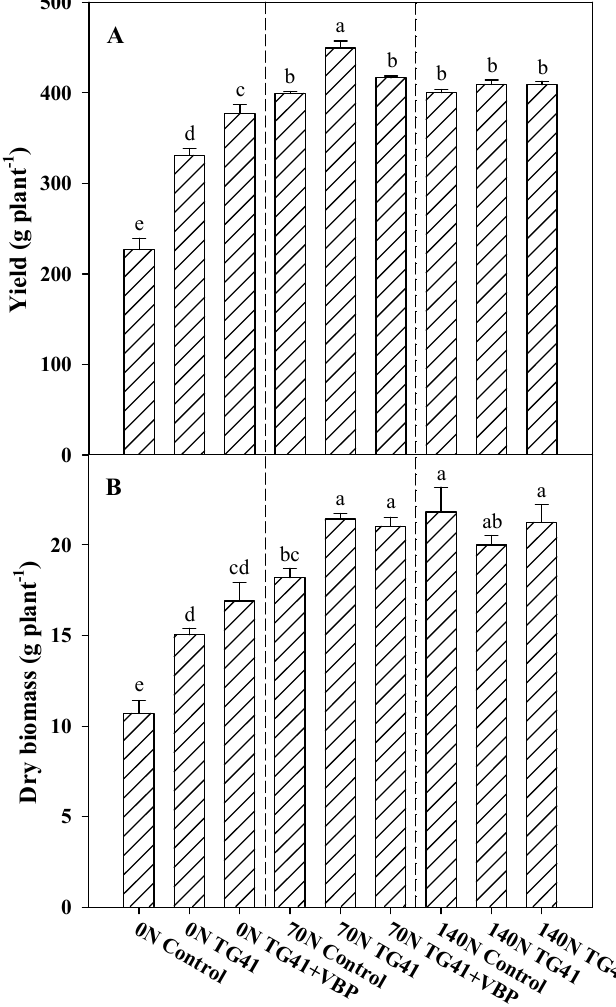
Figure 1. Fresh yield ( A ) and dry biomass ( B ) of Romaine lettuce grown in greenhouse in relation to N fertilization level (0N = 0 kg ha − 1 , 70N = 70 kg ha − 1 , 140N = 140 kg ha − 1 ) and biostimulant application (Untreated = Control, TG41 = T. virens G41, and TG41 + VBP = vegetal biopolymer-based biostimulant). Mean values with the same letter were not different, according to Duncan’s test ( p < 0.05).